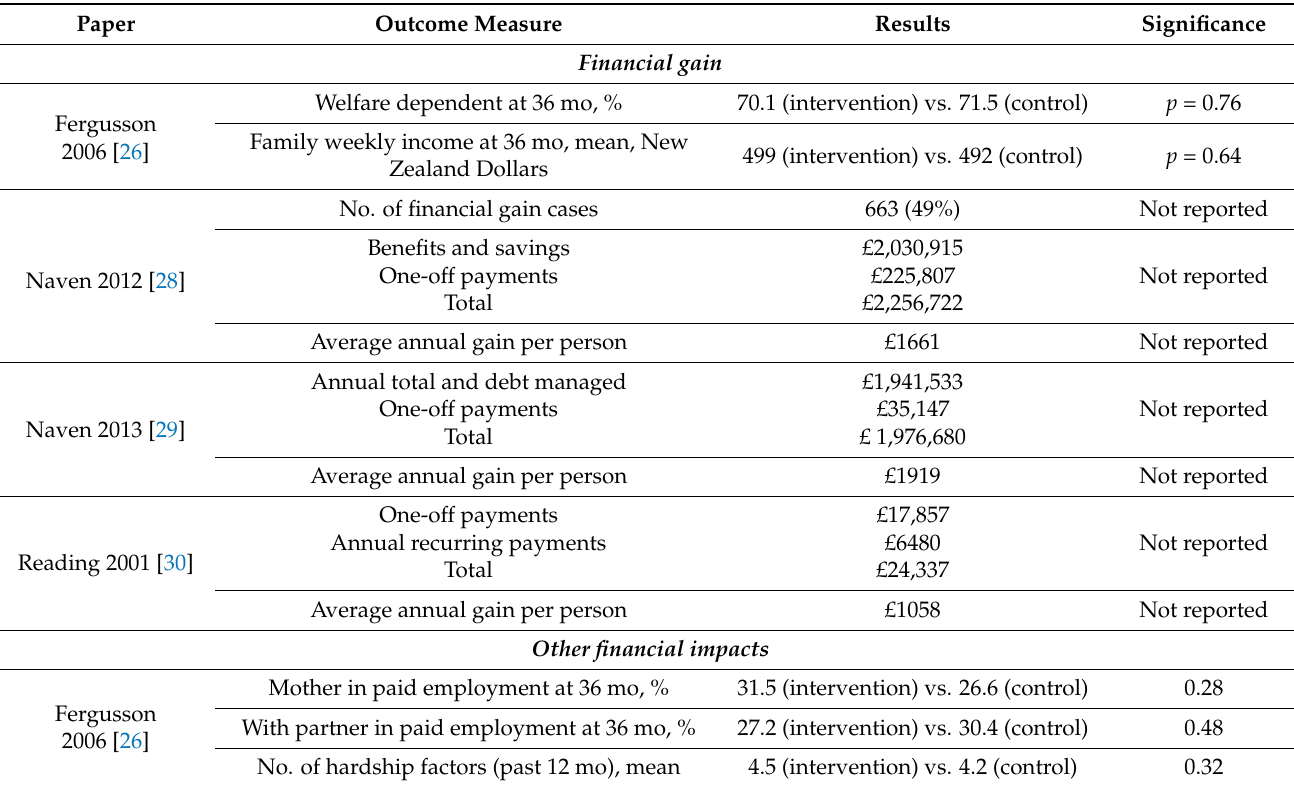
Table 3. Financial Impact.